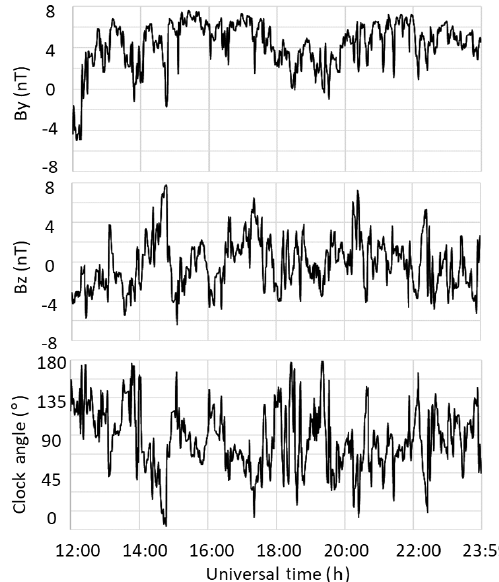
Figure 6. The y and z components of the IMF as well as the clock angle observed by the ACE spacecraft between 12:00 and 23:59UT on 10 December 2015, shown in the same format as Fig. 1. The data have been time-shifted to the nose of the Earth’s bow